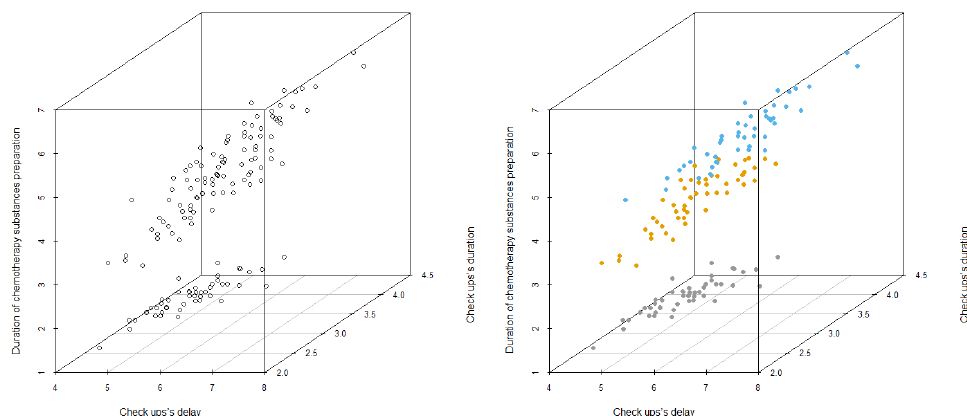
Figure 3. Illustration of the construction of 3 scenarios for patients by means of the k -means algorithm making use of 3 times involved in waiting times.